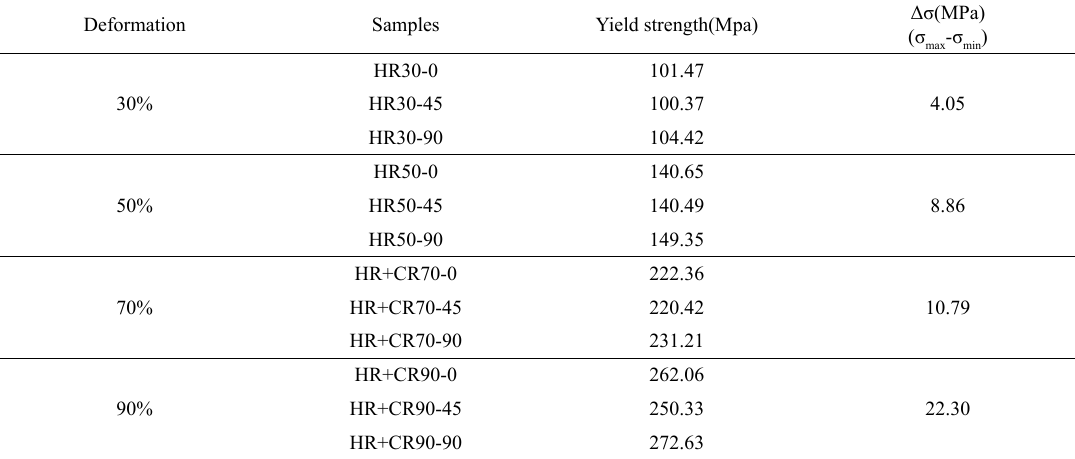
Table 4. Statistics of mechanical properties of